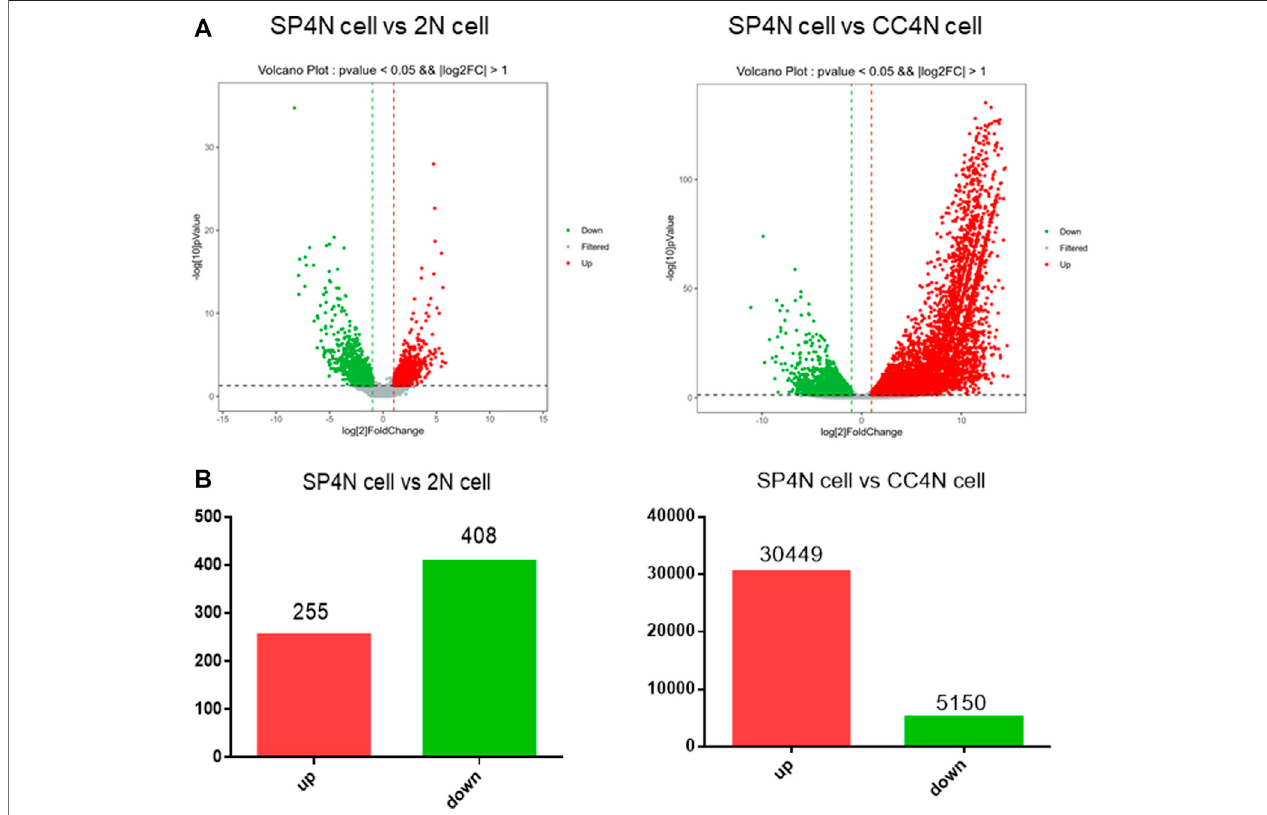
FIGURE4| Differentiallyexpressed genes(DEGs)betweentheSP600125 inducedtetraploidcells(SP4N cells)from C.auratus × C.carpio L. (CC4N cells) and the diploid fi shcells(2Ncells). (A) presentsthedistributionofDEGsinSP4Nand2N (leftlane) ,SP4NandCC4N (rightlane) . (B) presentstheup-ordown-regulatedDEGs in the three types of cells. Different expression levels of cell cycle genes in three types of